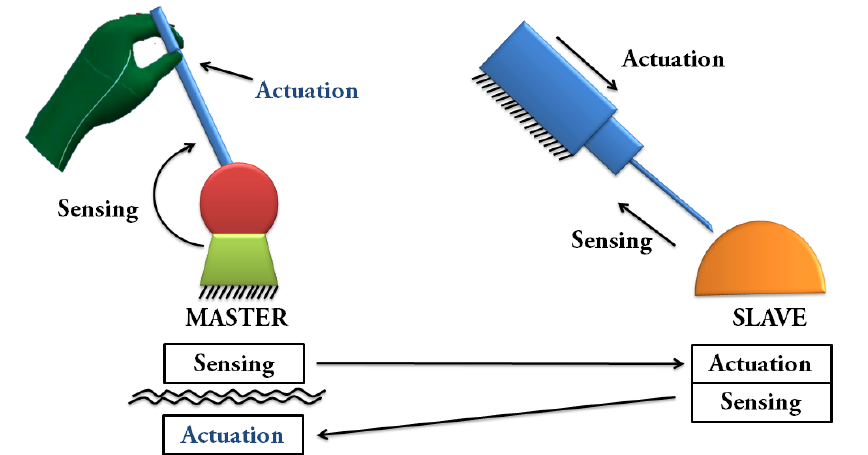
Figure 1. Teleoperation system with ungrounded cutaneous feedback to the operator based on the diagram by Paccheirotti et al. [5]. The cutaneous feedback to the human operator gives information about the forces exerted at the slave side and does not affect the stability of the control loop